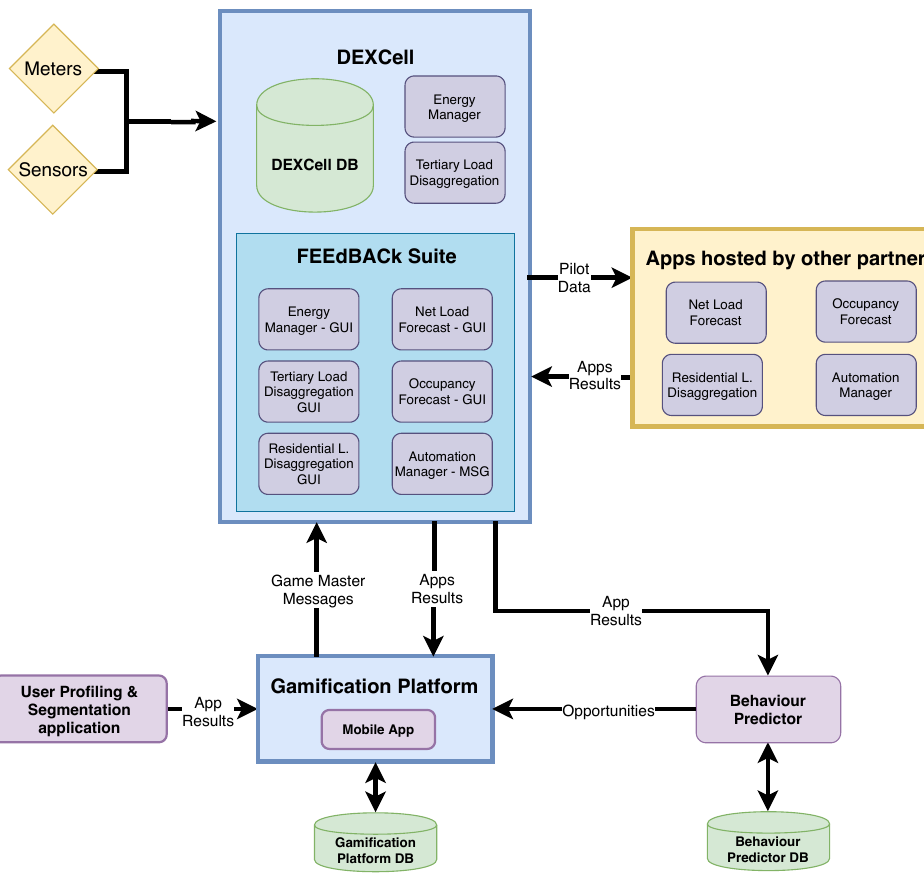
Figure 1. The integration block-scheme in FEEdBACk ICT-based